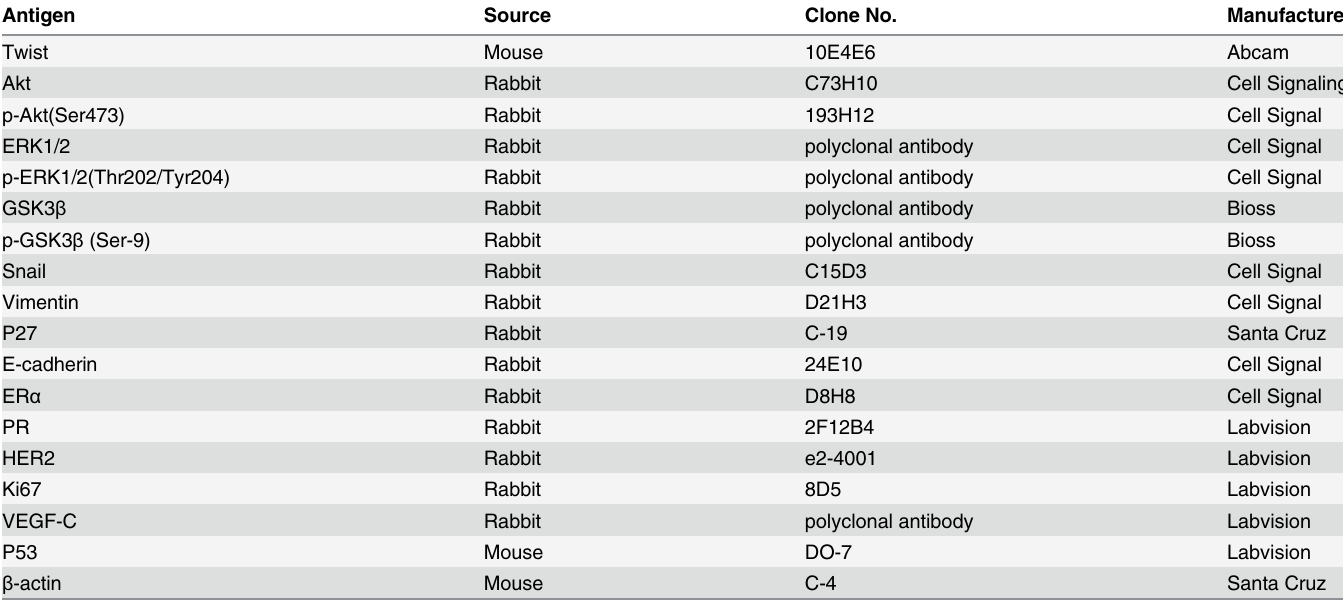
Table 1. Antibodies used in the